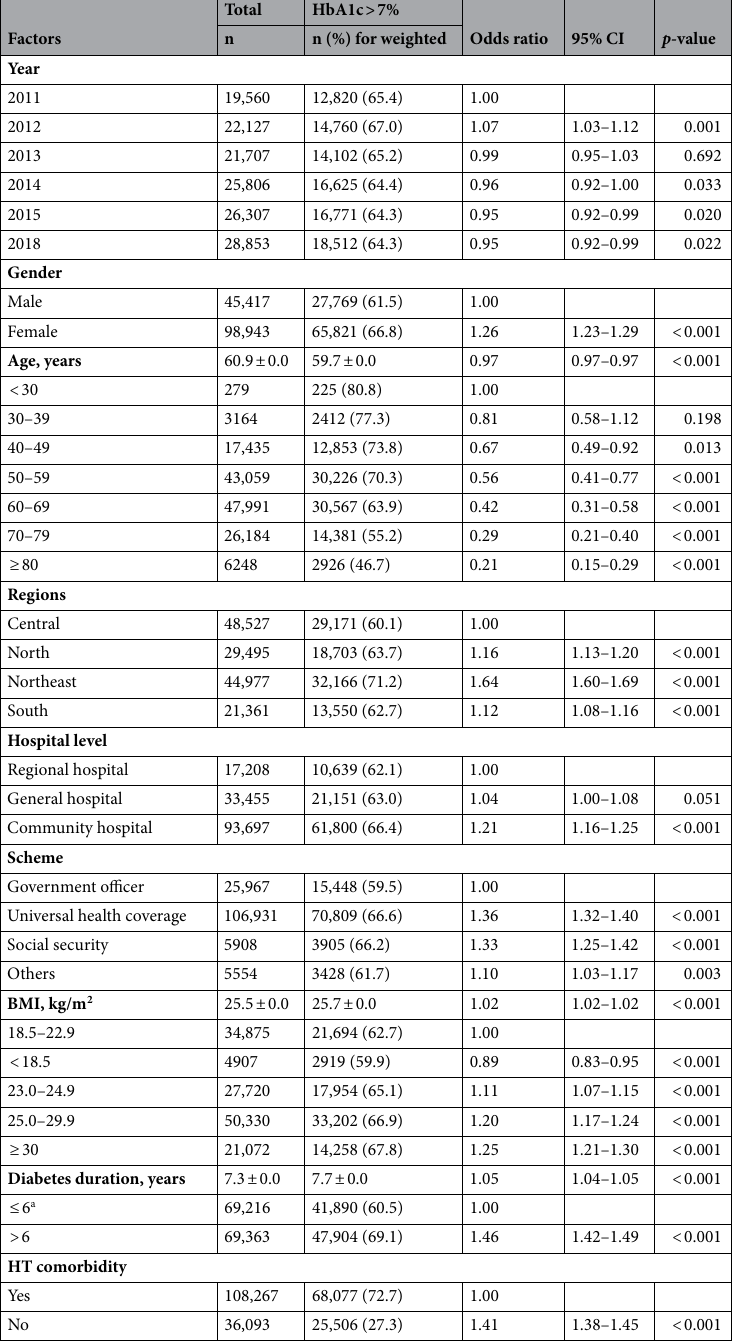
Table 3. Univariate analysis for factors associated with poor achievement of glycemic control (HbA1c ≥ 7%) among patients with type 2 diabetes in Thailand from 2011 to 2015 and 2018. BMI; body mass index, HT; hypertension, a cut-off points at the median, CI; confidence